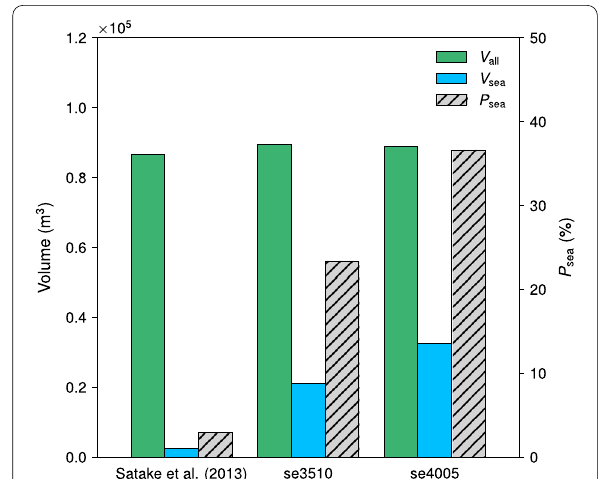
Fig. 8 Volumes of the whole deposits ( V all ) and marine-origin deposits ( V sea ) around the Suijin-numa pond (simulated according to the method by Masaya et al. 2021). Ratios P sea = V sea / V all for each case are